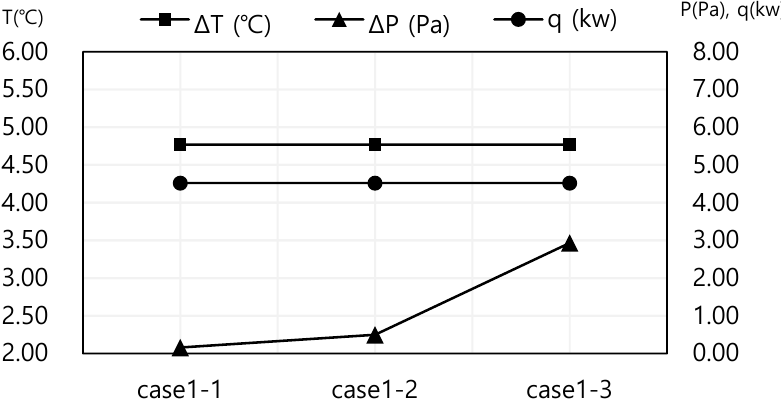
Figure 6. Change in temperature, pressure, and thermal capacity with length.